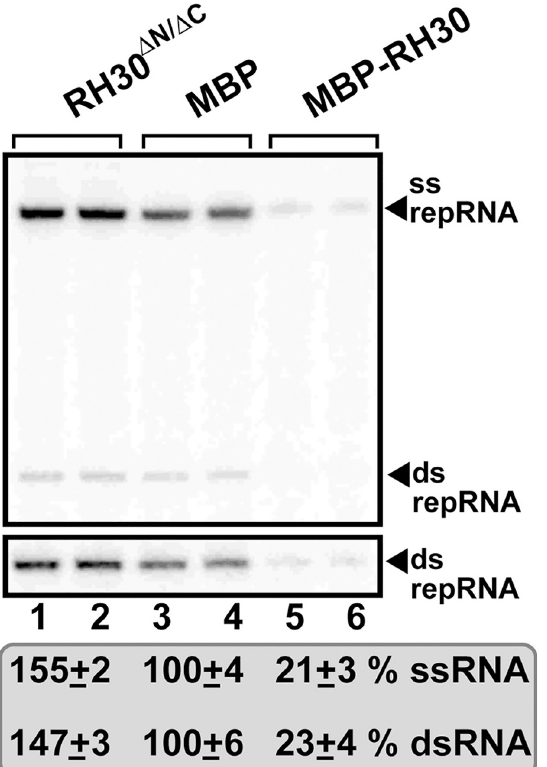
Fig 3. Enhanced TBSV repRNA accumulation by RH30 Δ N/ Δ C helicase in an in vitro replicase reconstitution assay based on CFE obtained from wt yeast. The purified recombinant tombusvirus p33 and p92 pol replication proteins from E . coli were added in combination with the template (+)repRNA to program the yeast CFE preparation in vitro. The affinity-purified recombinant MBP-RH30 Δ N/ Δ C (1.9 μ M), MBP-RH30 (1.9 μ M) or MBP (1.9 μ M), as a control, were added to the reactions. Non-denaturing PAGE shows the accumulation of 32 P-labeled (+)repRNA and the dsRNA replication intermediate products made by the reconstituted TBSV replicases. The bottom image shows the enhanced image of the dsRNA products in the top image. Each experiment was repeated three